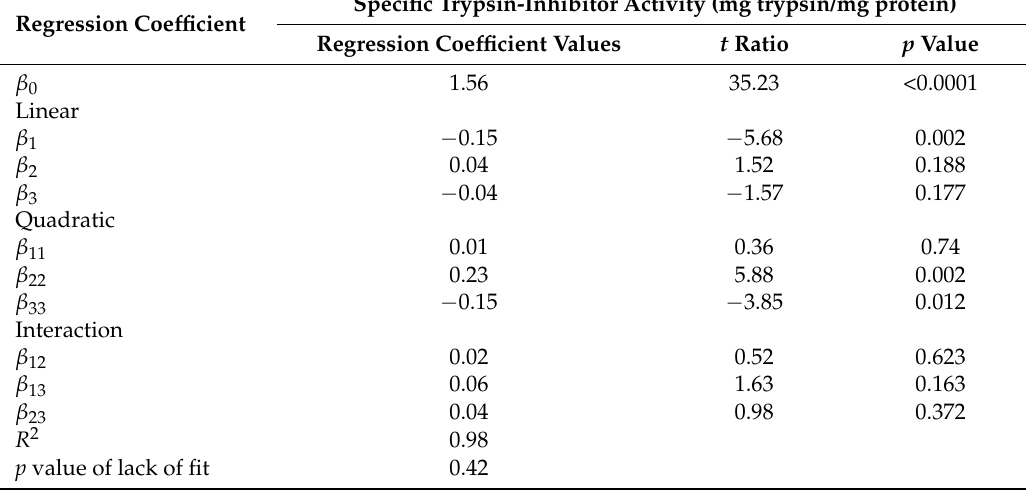
Table 5. The regression coefficients and their significance values generated from the fitted 2 nd order equation for the Box–Behnken